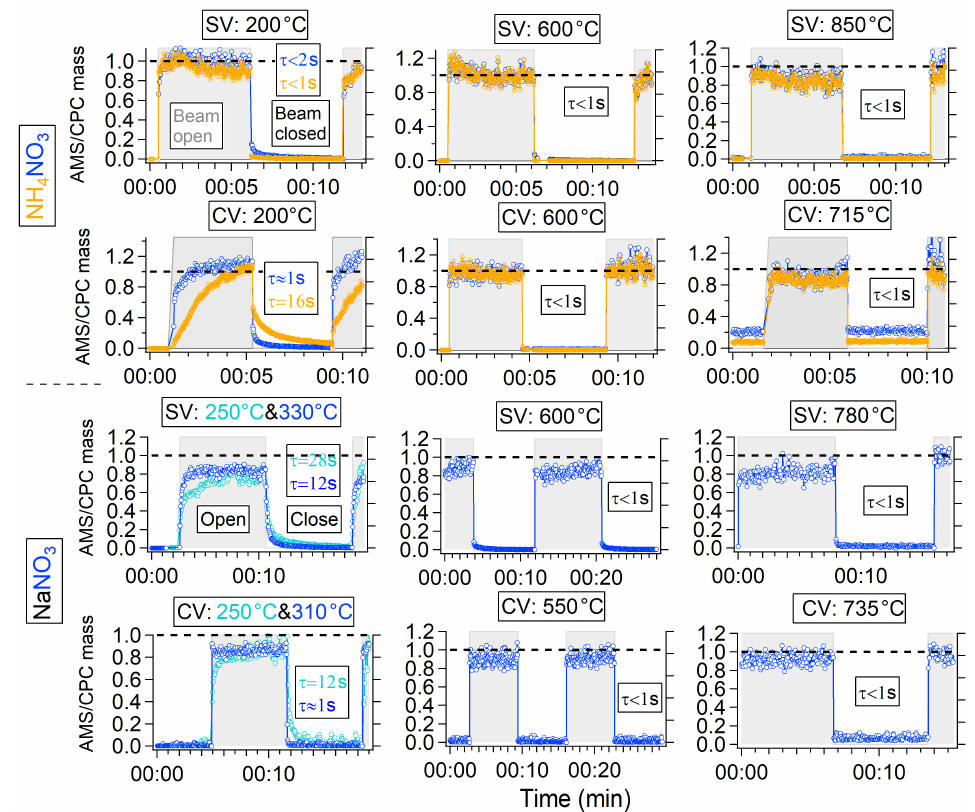
Figure 10. Results of an experiment slowly alternating beam-open and beam-closed positions while sampling NH 4 NO 3 and NaNO 3 in the SV and CV. Note that the total signal (and not just the difference signal) is shown in all panels. The results from three/four different vapourizer temperatures (low, medium and high within the usable range) for each species are shown. τ is the lifetime of signal decay and was estimated through an exponential fit to the relevant part of the time series. τ for the rising signal is not shown, since it always varies in the same